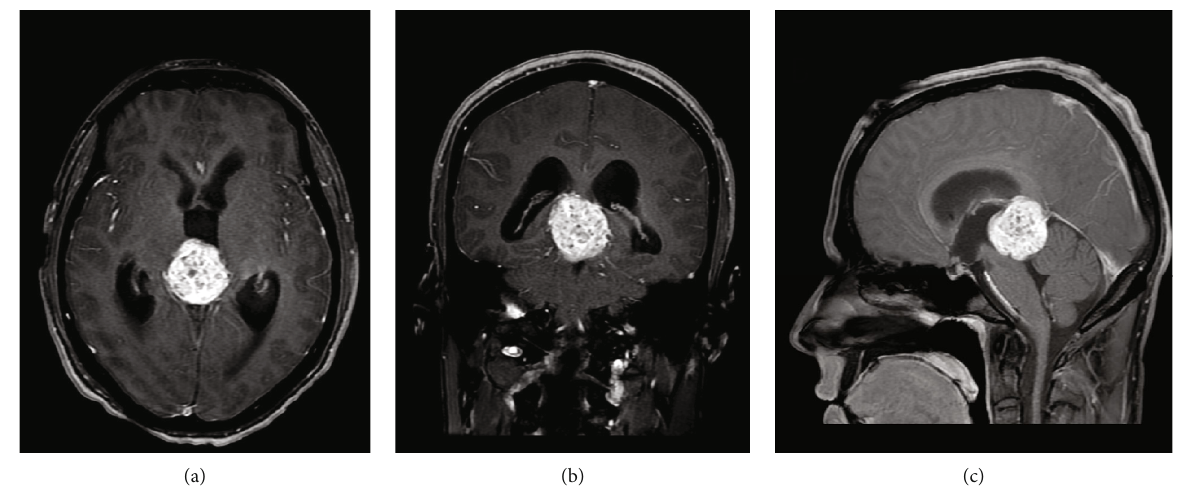
Figure 1: (a) Axial, (b) sagittal, and (c) coronal view of the intracranial germinoma. Note the obstructive pattern of the tumor giving obstructive